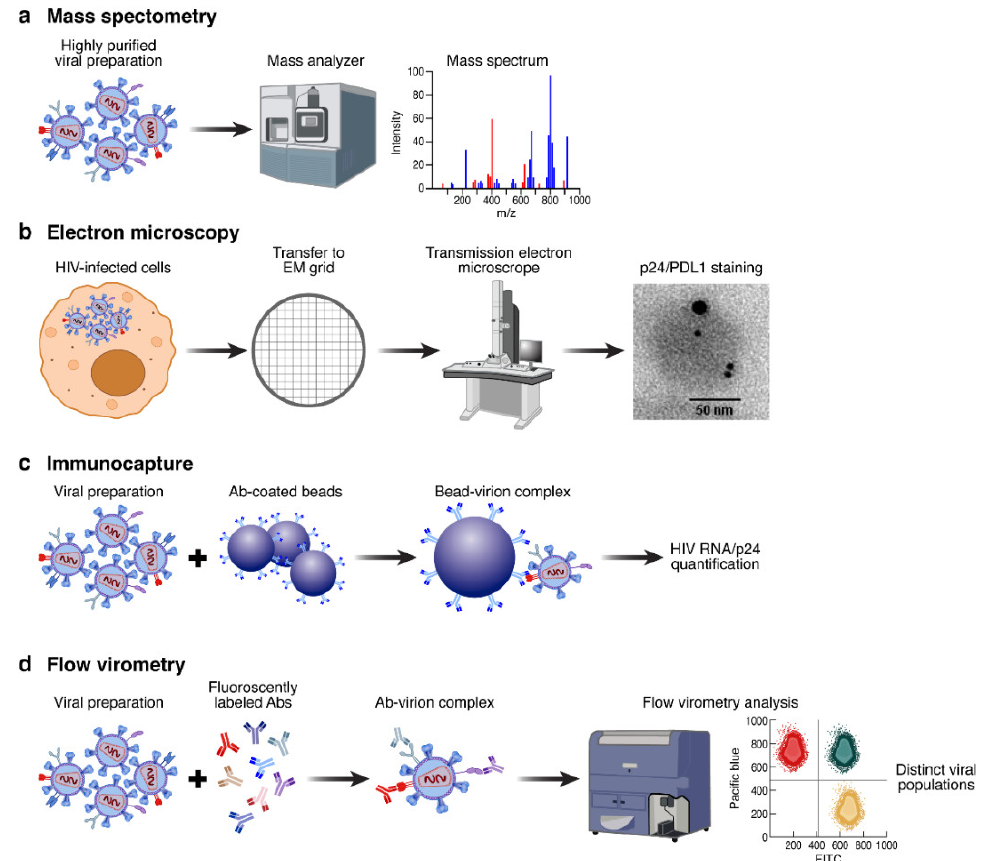
Figure 1 . Methods to characterize host protein incorporation into HIV virions: ( a ) mass spectrometry is the gold standard to deeply characterize protein compositions of viral preparations; ( b ) electron microscopy and more recently the use of immuno-gold labeling are becoming standard tools to characterize host protein interaction/incorporation in HIV virions; ( c ) the immuno-capture of HIV virions is a two-step process; first, the capture using beads or plates coated with mAbs and second, the detection of either HIV RNA or p24 to quantify HIV virions; and ( d ) flow virometry represents a promising tool, where HIV virions could be detected and characterized using fluorescently labeled mAbs.